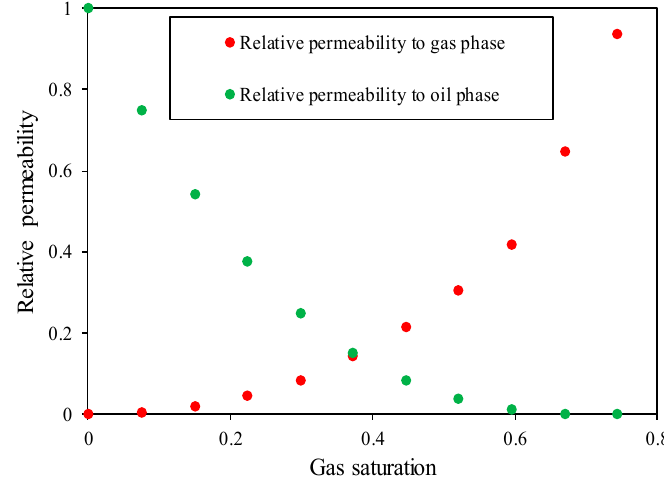
Figure 4. Relative permeability curve used as input for the semi-analytical and numerical model.